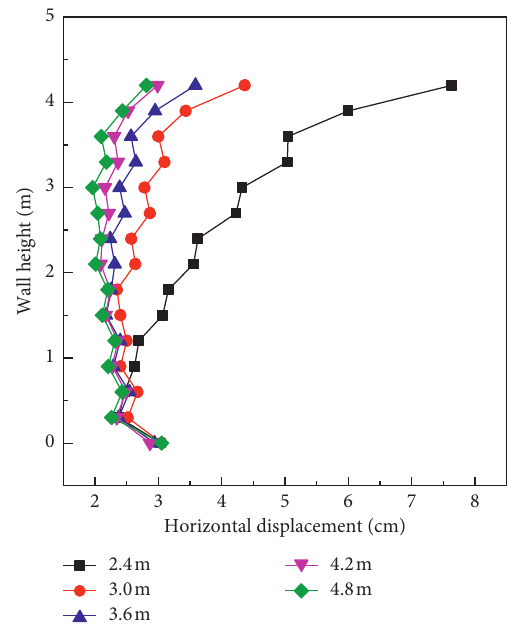
Figure 13: Horizontal displacement of the retaining wall under different geocell